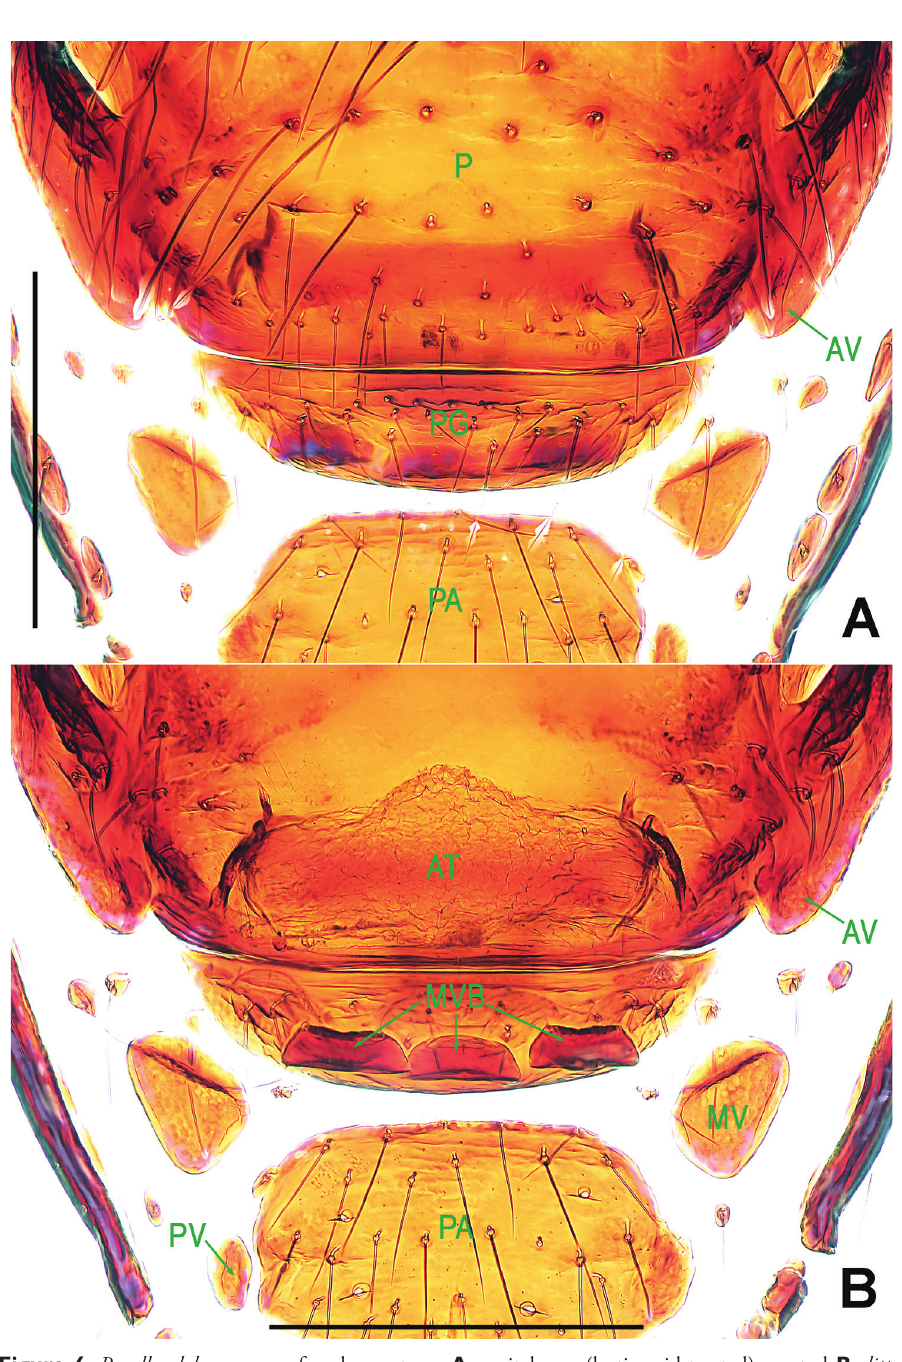
Figure 6. Paculla globosa sp. n., female paratype. A genital area (lactic acid-treated), ventral B ditto , dorsal. Abbreviations: AT = atrium; AV = anterior ventrolateral plate; MV = median ventrolateral plate; MVB = bridge fragments of MV; P = pulmonary plate; PA = preanal plate; PG = postgenital plate; PV = posterior ventrolateral plate. Scale bars: 0.50